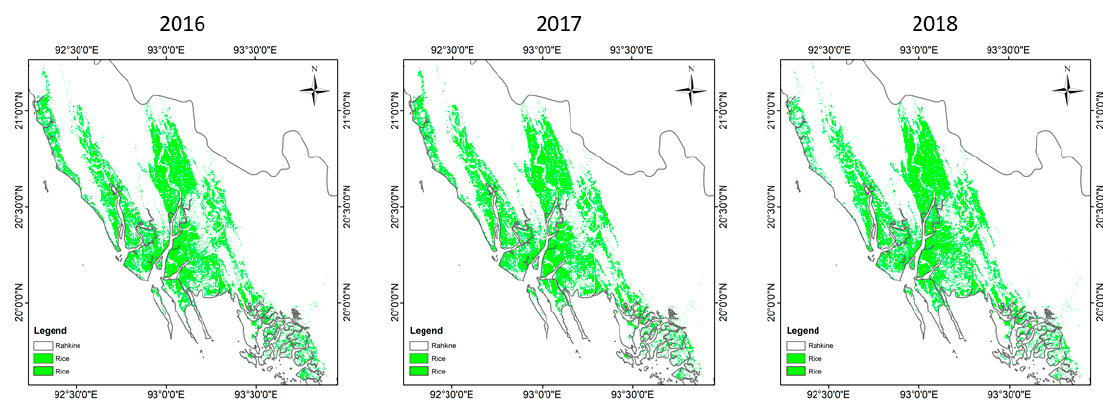
Figure 5. Example Sentinel-1 VH time series aggregated to the broad land use—land cover classes illustrating varying phenological patterns attributed to cropping dynamics.